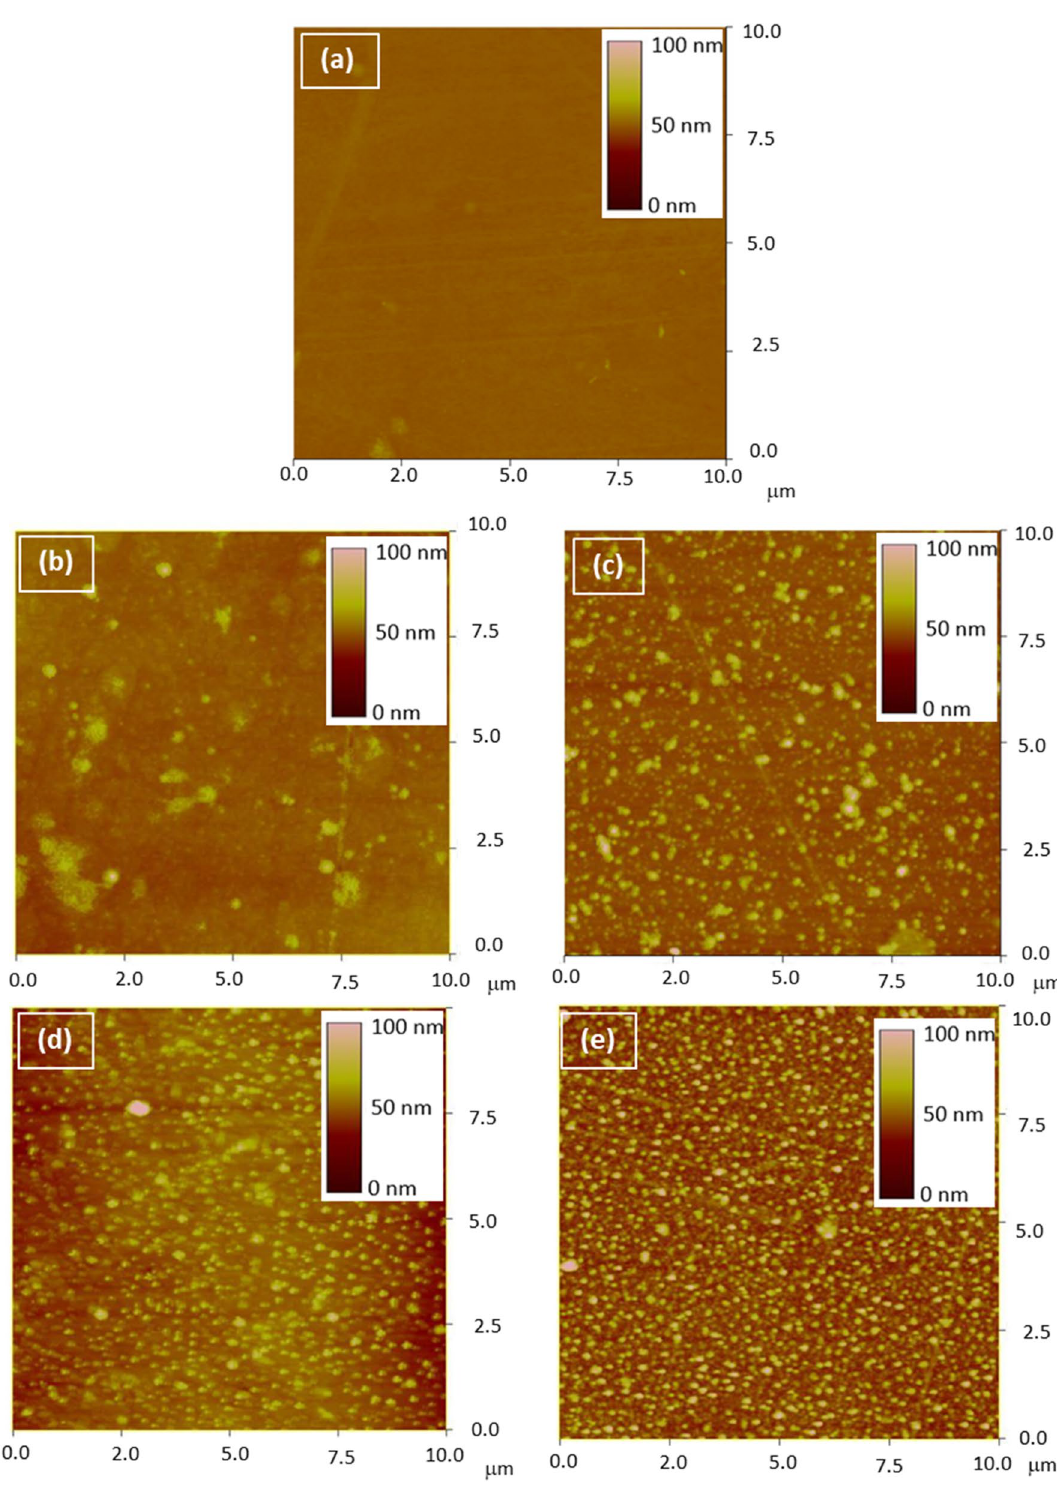
Figure 7. AFM images of the uncoated specimen ( a ) and specimens subjected to 2, 4, 6, and 8 scans ( b – e ),